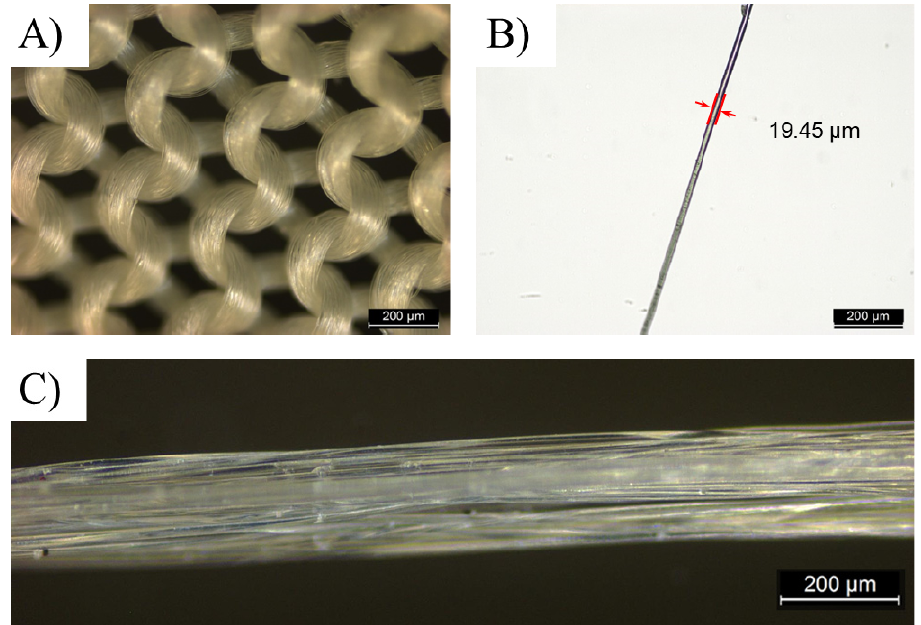
Figure 2. Digital microscopic photograms of ( A ) original PLA/PHB knitted fabric, ( B ) one PLA/PHB fiber from multifilament yarns and ( C ) multi-filament yarns used in fabrics.